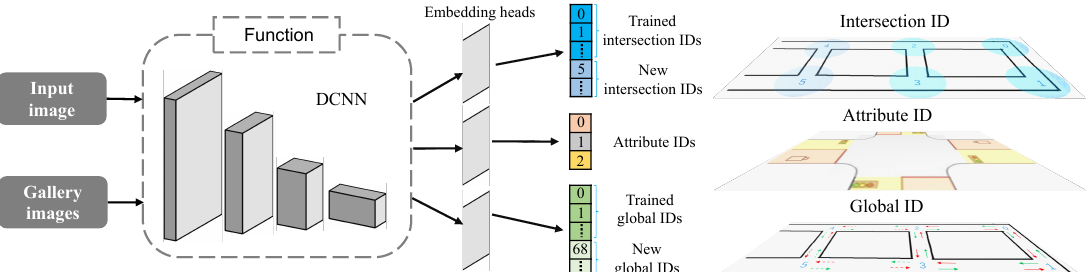
Figure 2. Multi-task of traffic intersection re-identification, which consists of determining the intersection ID, attribute ID, and global ID. The attribute ID denotes the interaction between ego-car and intersection, with 0 indicating at the entrance of the intersection, 1 for inside the intersection, and 2 for at the intersection exit. The intersection IDs and global IDs respectively represent different intersection areas and global poses (assigned with information of location and driving direction). Both of them can be partitioned into existing gallery IDs and new